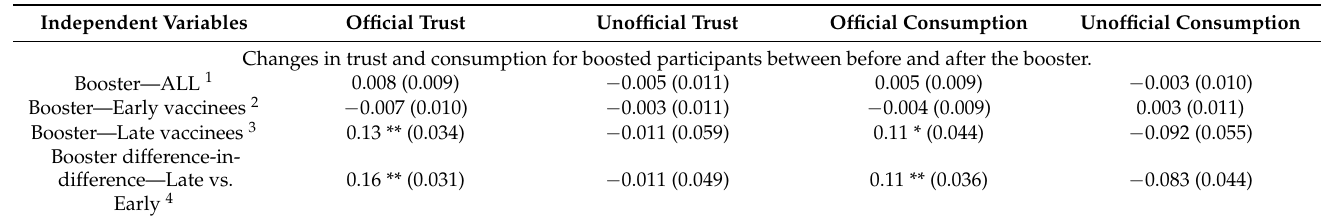
Table A4. Regression results outlying the longitudinal changes of returning participants with boosters on trust in and consumption of official and unofficial information sources before and after the booster shot. The four rows below focus on everyone with booster shots, every early vaccinee, every late vaccinee, and the differences between early and late vaccinees in these changes, respectively. These results are based on OLS regressions, and the coefficients are directly interpretable as unit percentage changes.